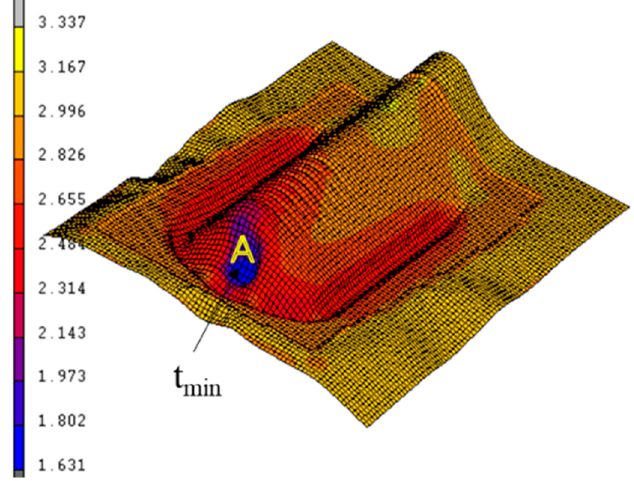
Figure 6. Thickness distribution of the drawing during the preforming process. (3)